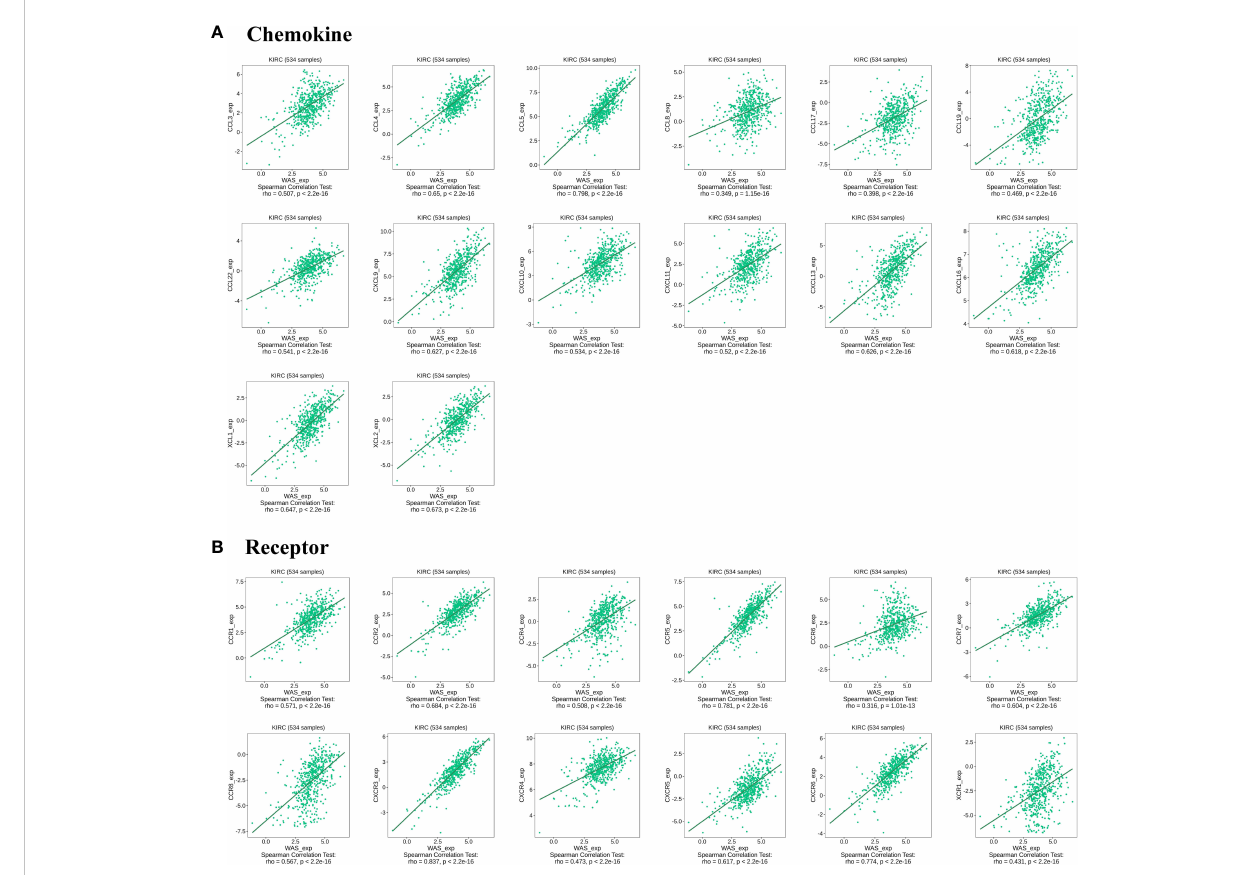
FIGURE 9 Correlation between WAS and immunoregulatory factors in ccRCC. (A) Correlation between WAS expression in ccRCC and chemokines in TISIDB database. (B) Correlation between WAS expression and chemokine receptors in ccRCCs in the TISIDB